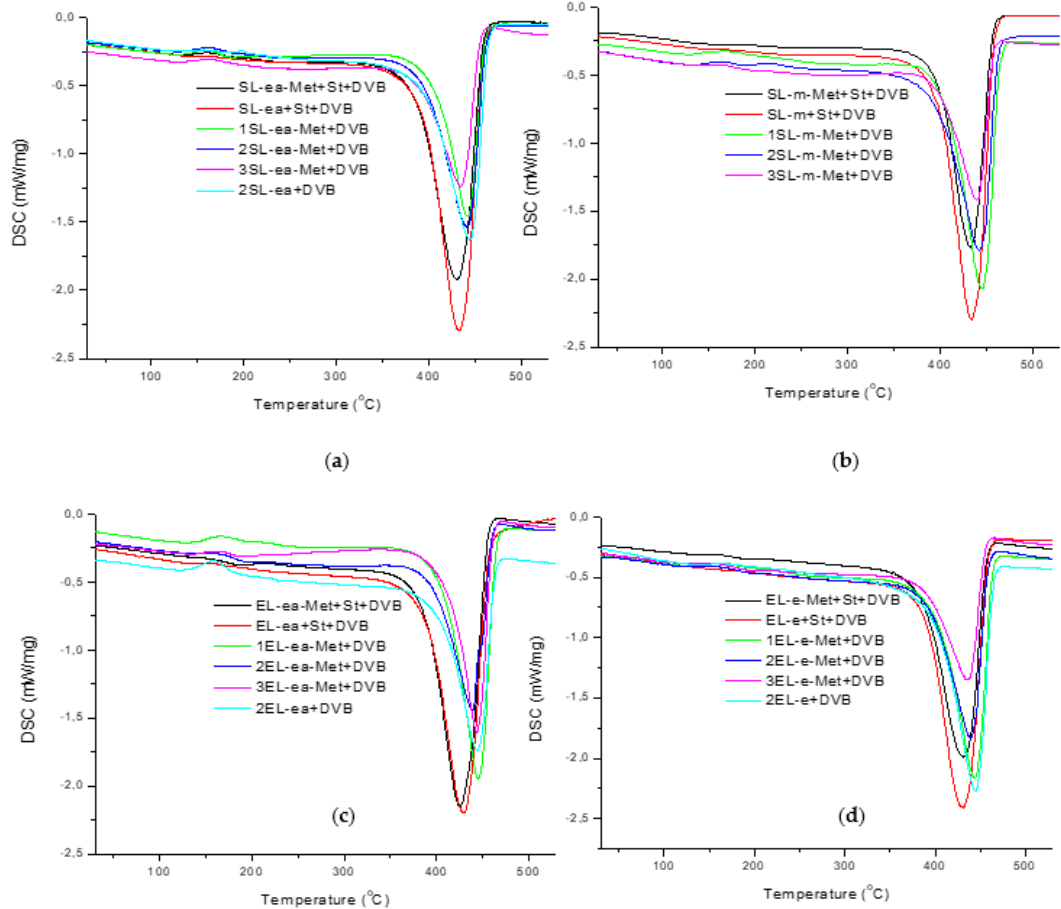
Figure 3. DSC curves of polymers containing ( a ) SL-ea, ( b ) SL-m, ( c ) EL-ea, ( d ) EL-e.